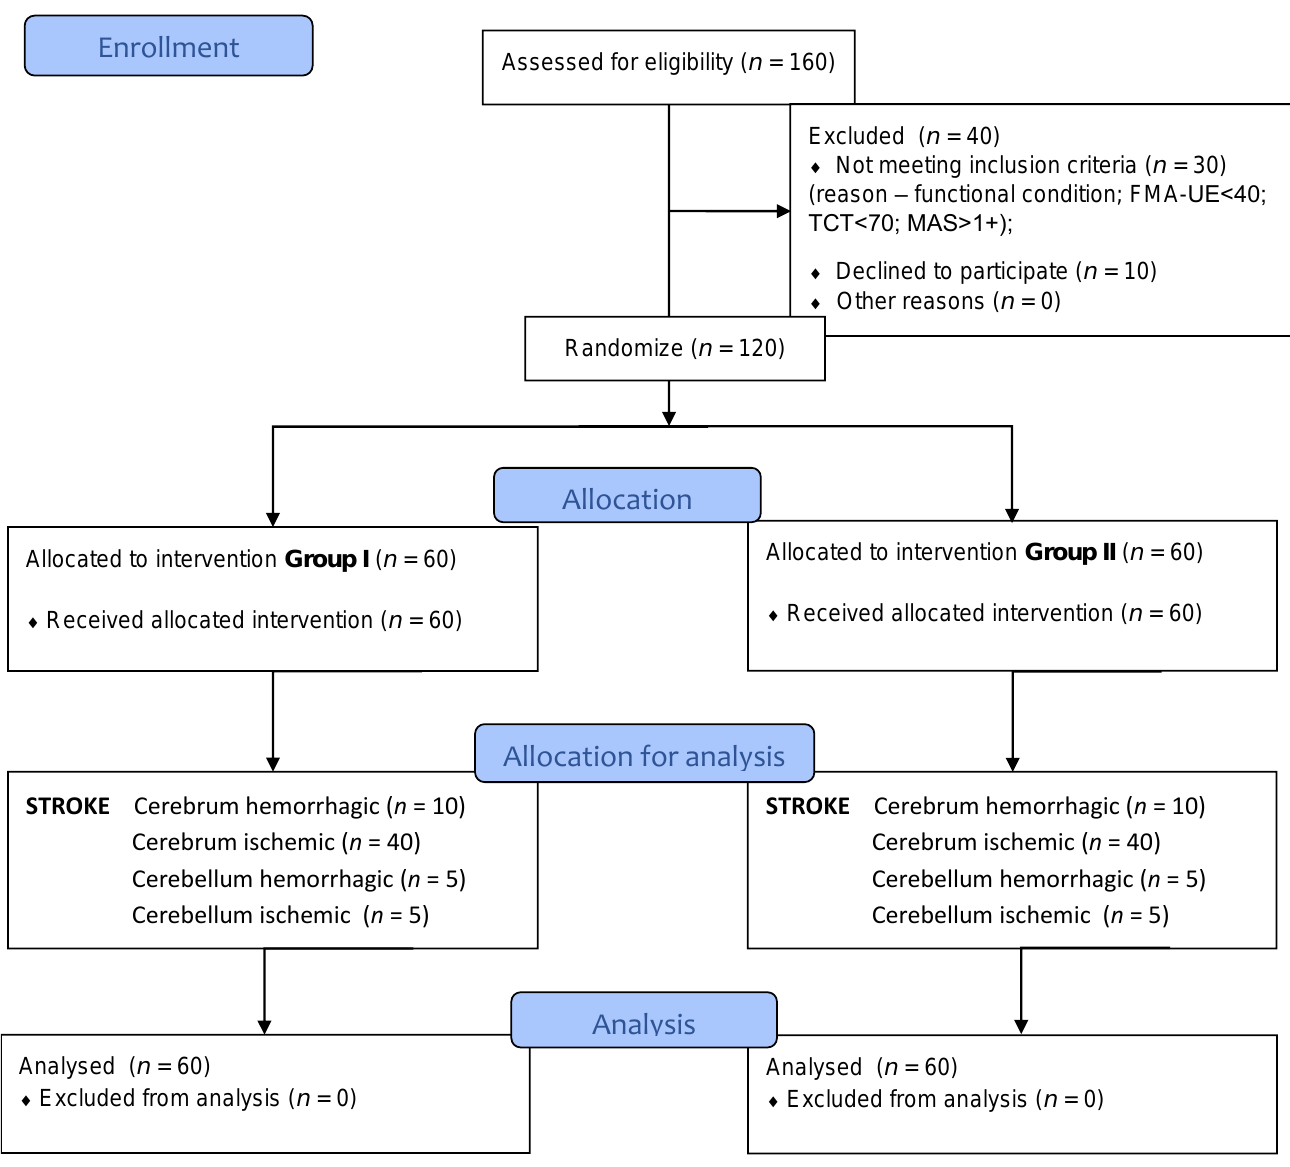
Figure 1. Flow of participants through each stage of the study.